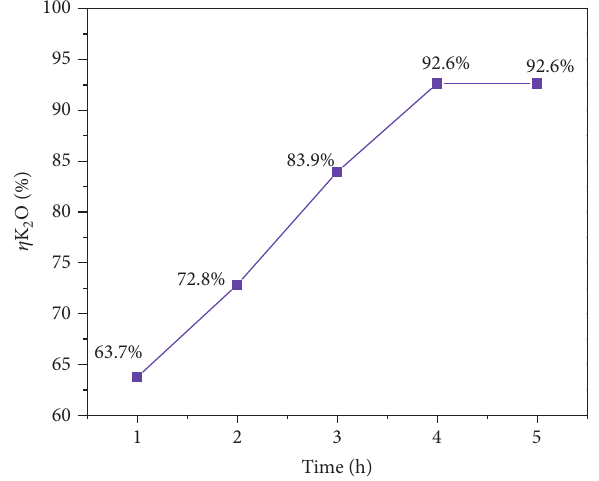
Figure 8: The results of potassium extraction rates at 175 ∘ C for different crystallization times (1h to 5 h) in 0.5 mol/L NaOH